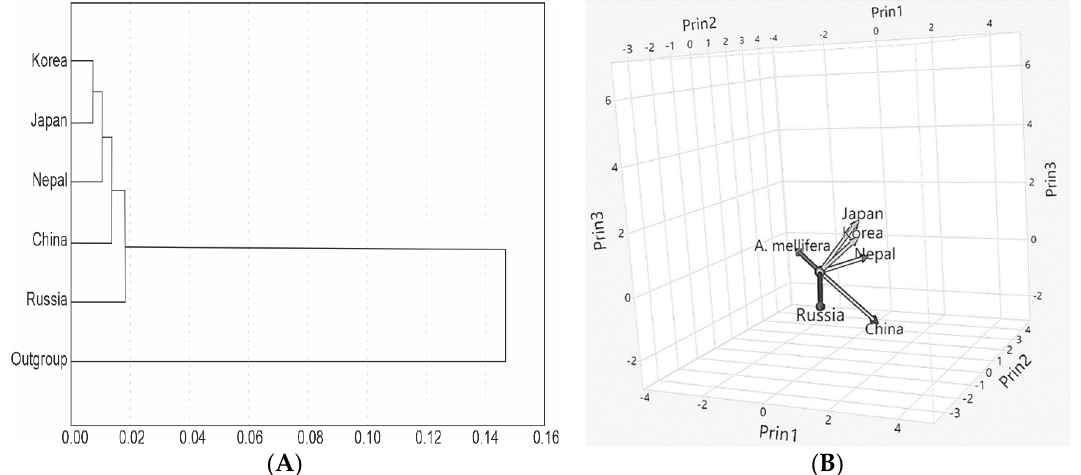
Figure 3. Neighbor-joining phylogenetic tree ( A ) and three-dimensional PCA plot ( B ) based on Jukes–Cantor genetic distances between VG gene sequences of five A. cerana and one outgroup A. mellifera populations. Table 3. Tajima’s neutrality test for five A. cerana populations based on the VG gene sequences.